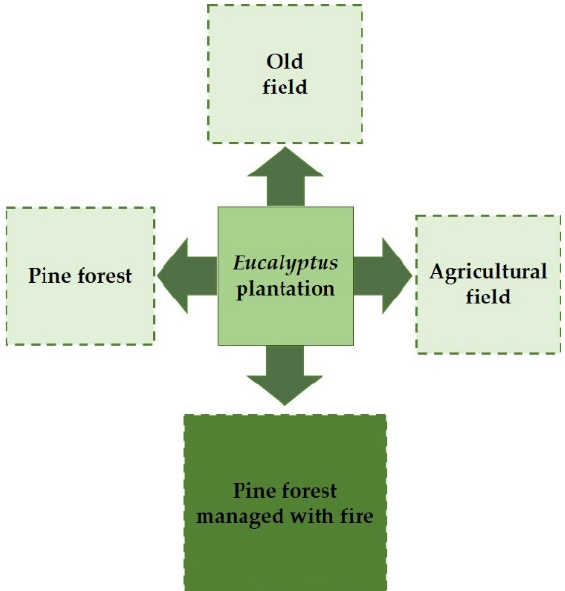
Figure 1. Potential pathways for Eucalyptus invasion in the southeastern US .